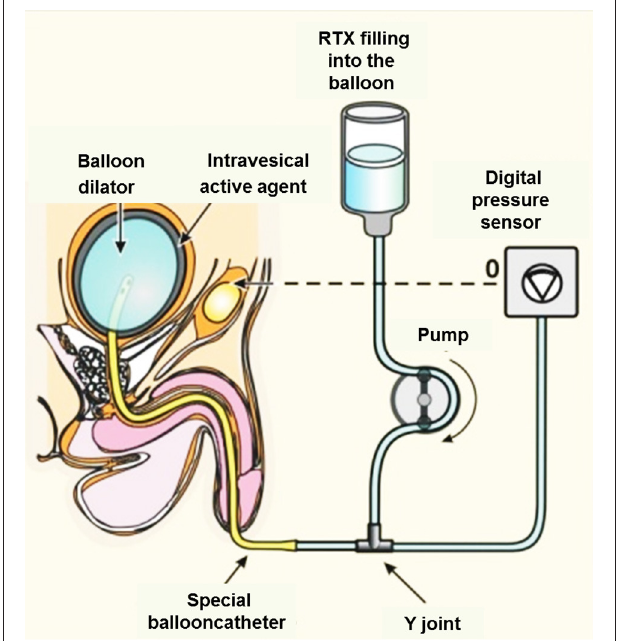
FIGURE 4 | Topical intravesical medication of RTX via transurethral instillation promises several advantages over oral systemic CAP therapy. Intravesically administered RTX penetrates the vesical mucosa and submucosa by diffusion and binds to TRPV1 + nerve endings. The suggested “balloon dilator” method benefits from the increased surface of urothelium due to the thinning of the bladder